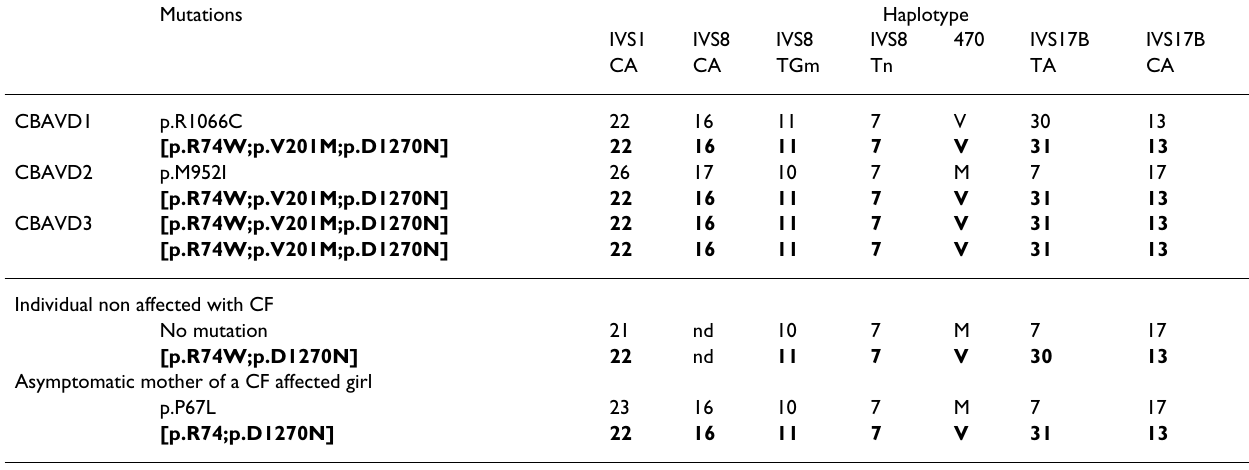
Table 2: CFTR sequence changes found in individuals carrying missense alterations p.R74W, p.D1270N, or